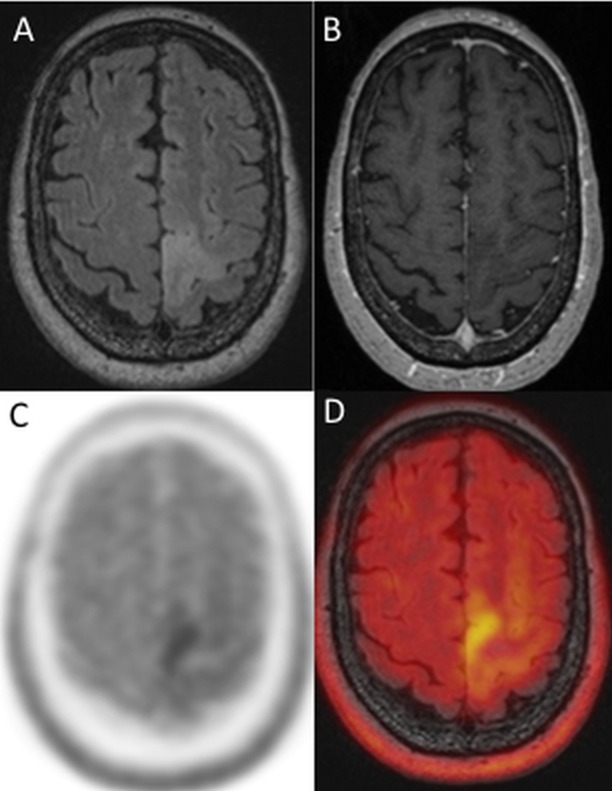
Astrocytoma WHO grade II.71-year old female patient with left sided pre-/central FLAIR—hyperintensity (A) without contrast enhancement (B). Integrated methionine PET showed a focal pathologic tracer uptake (SUVmax 2.5 T/N, ratio 2.27) of this lesion (C, D (fusion of FLAIR and PET)). Diagnosis was an astrocytoma WHO grade II.